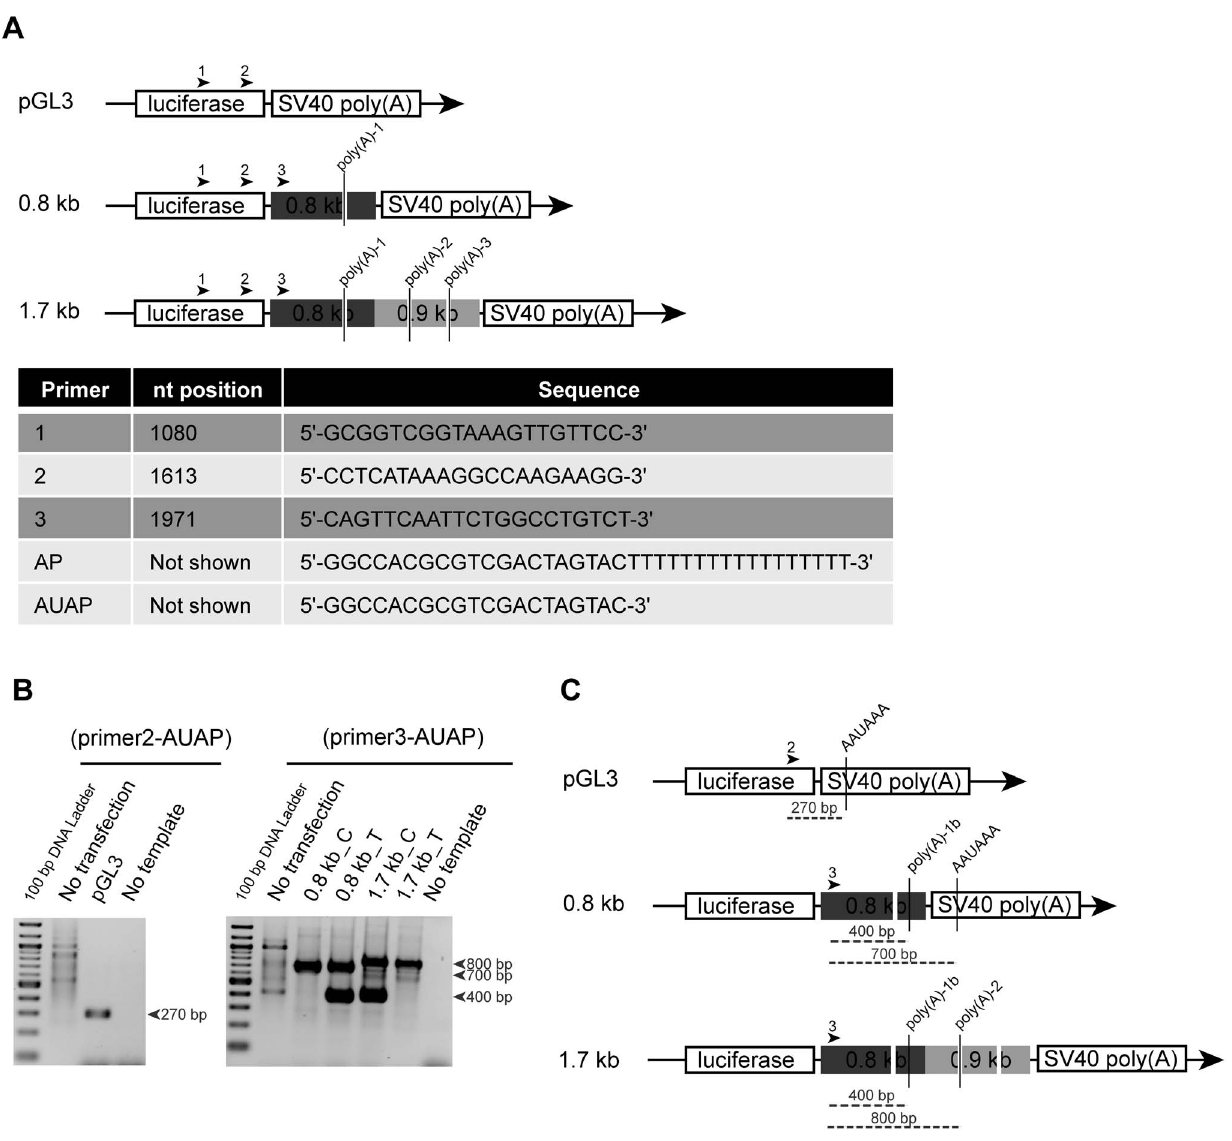
Figure 4. The use of alternative CHRNB4 poly(A) signals depends on SNP rs1948 and length of construct. (A) Schematic representation of the empty pGL3 vector and 0.8 kb and 1.7 kb constructs. Predicted poly(A) signals are indicated in each construct in between primers used. The numbers above each construct indicate gene-specific primers used. The table below shows the nucleotide position of each primer, relative to the transcription initiation site of luciferase gene, and its sequence. (B) Re-amplified PCR products using pairs of primers (2-AUAP) for pGL3 cDNA templates and (3-AUAP) for 0.8_C/T kb and 1.7_C/T kb constructs. (C) Schematic representation of each construct showing the real poly(A) signal used in each case, determined by the amplification product obtained (dashed grey lines) using pair of primers (2-AUAP) and